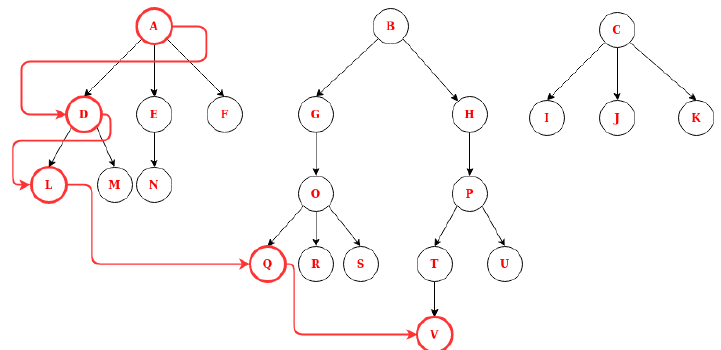
Figure 3. Leftmost